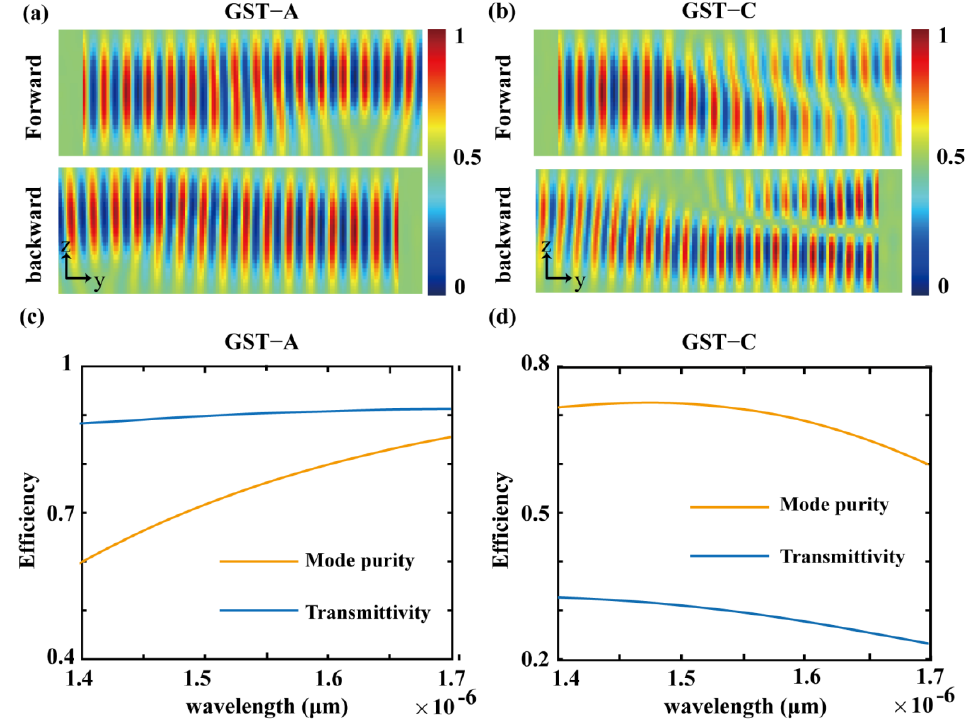
Figure 4. ( a ) When GST-225 is in the amorphous state, TE0 mode can be output in TE0 mode at the forward or backward transmission. ( b ) When the GST-225 is in the crystalline state, the TE0 mode and the TE1 mode are transmitted in the forward and backward transmission, and another mode is obtained at the output. ( c , d ) When GST-225 is in the amorphous and crystalline state, the transmission efficiency and mode purity distribution differ at different wavelengths.